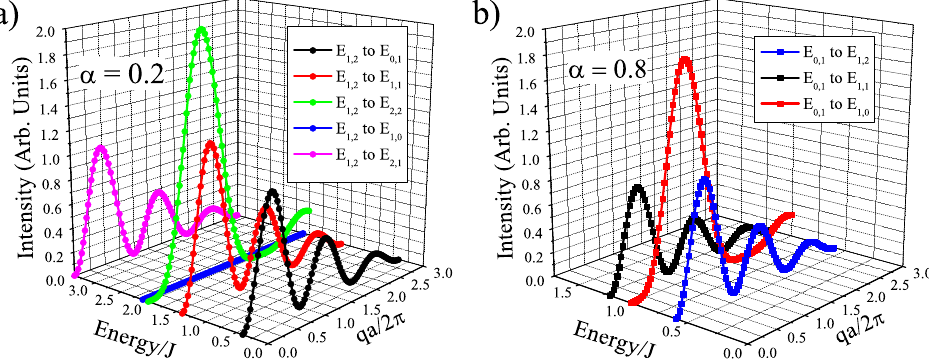
Figure 4. ( a ) S = 1 isosceles trimer single-crystal structure factors as a function of E/J vs. q with S t = 1 ground state at α = 0.2 ( a ) and with S t = 0 ground state at α = 0.8 ( b ). Here, r 12 = r 13 /2 = r 23 /2 = a, where a is the spatial distance of the dimer. We also include a generic magnetic form factor to illustrate the damping effect that will be expressed at larger q [40]. Note: Different colors were used to differentiate the different transitions for that particular α .